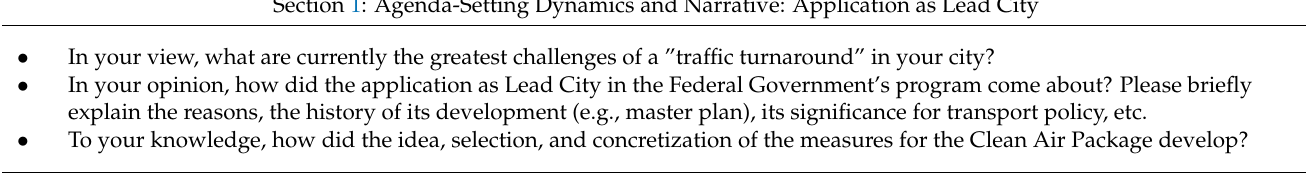
Table 3. The questionnaire that was used for the semi-structured expert interviews. Section 1: Agenda-Setting Dynamics and Narrative: Application as Lead